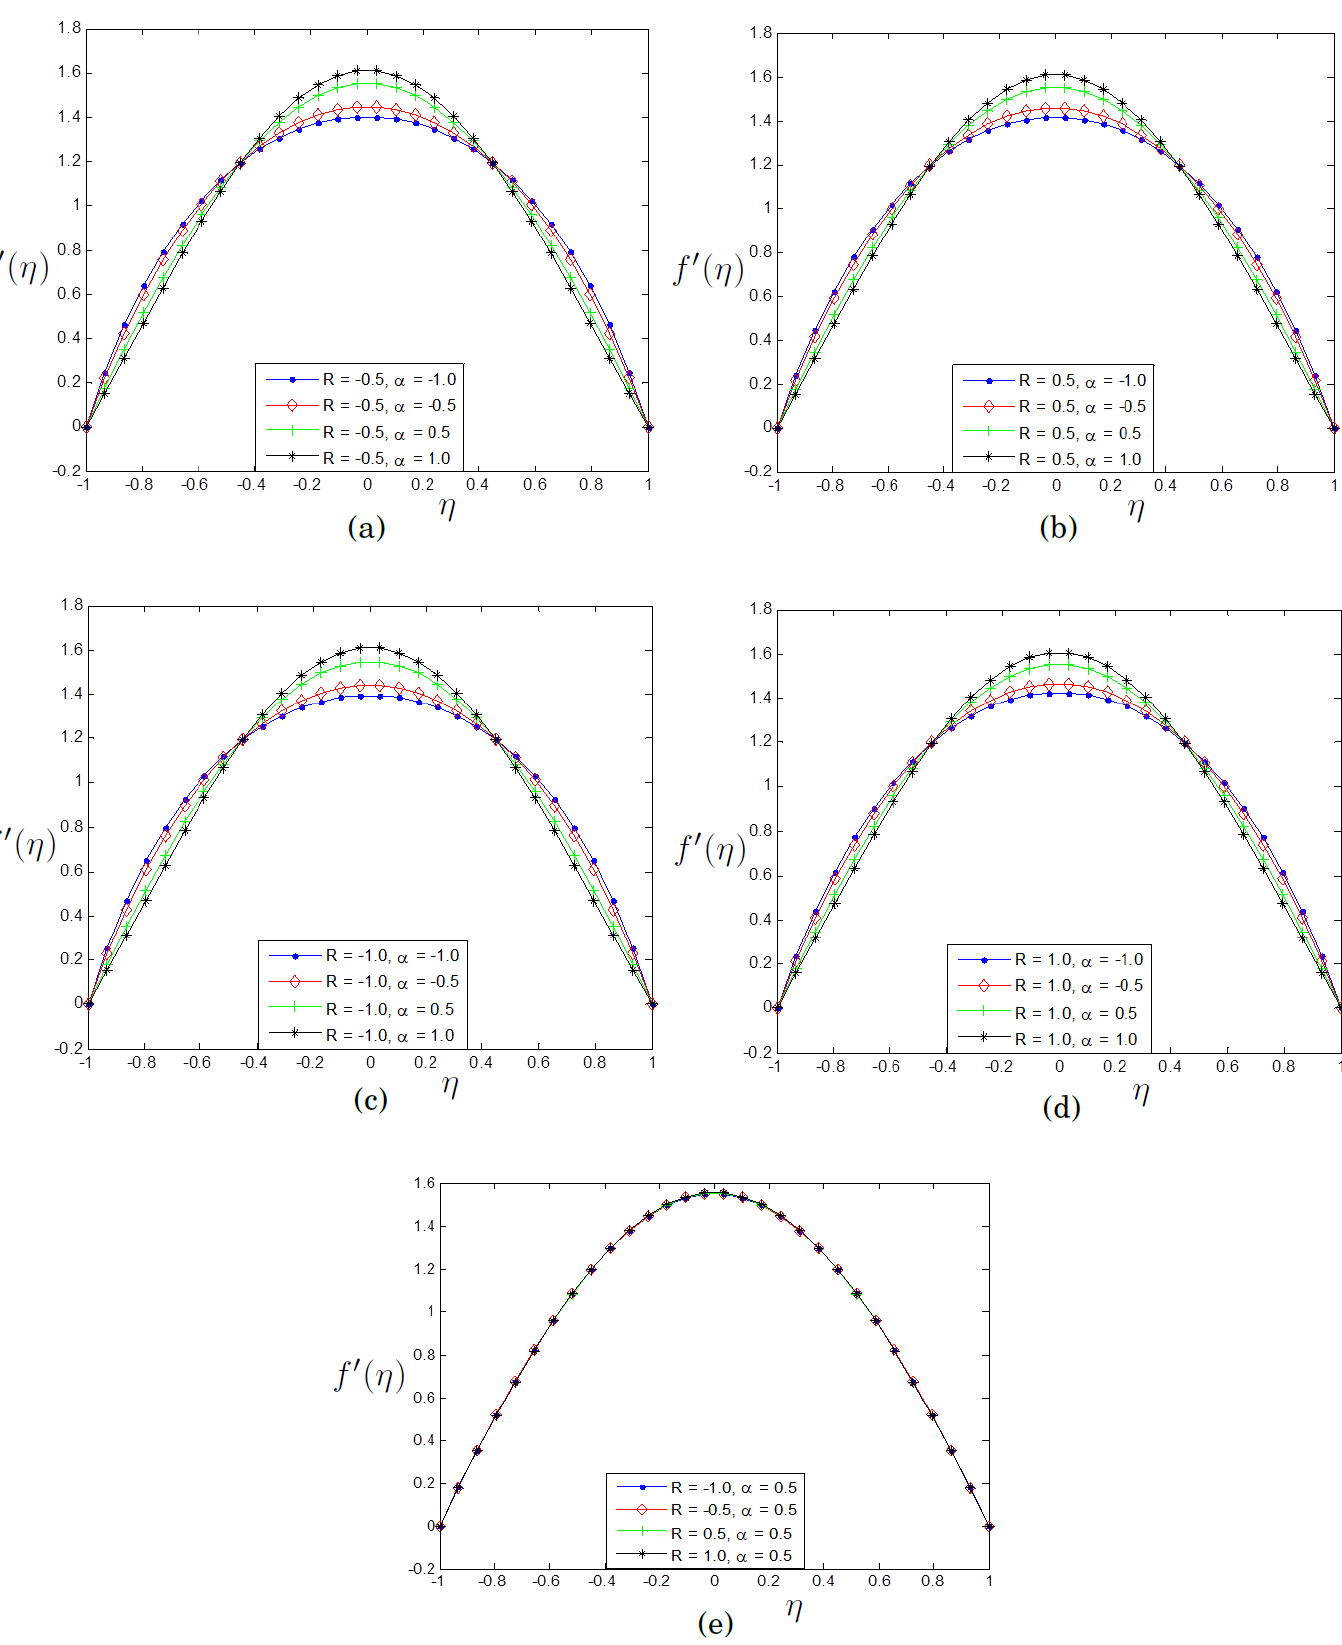
Figure 2: Variation of f (cid:48) ( η ) for different expansion and contraction ratio, α and Reynold